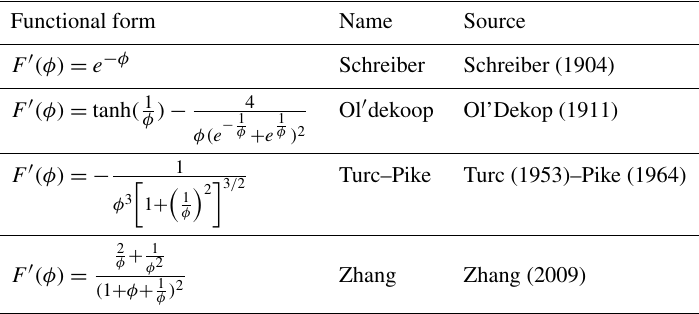
Table 4. Mathematical form of F (cid:48) (φ) , where φ refers to the aridity index, and F(φ) is a mathematical function relating the runoff ratio to precipitation (or PET) to the aridity